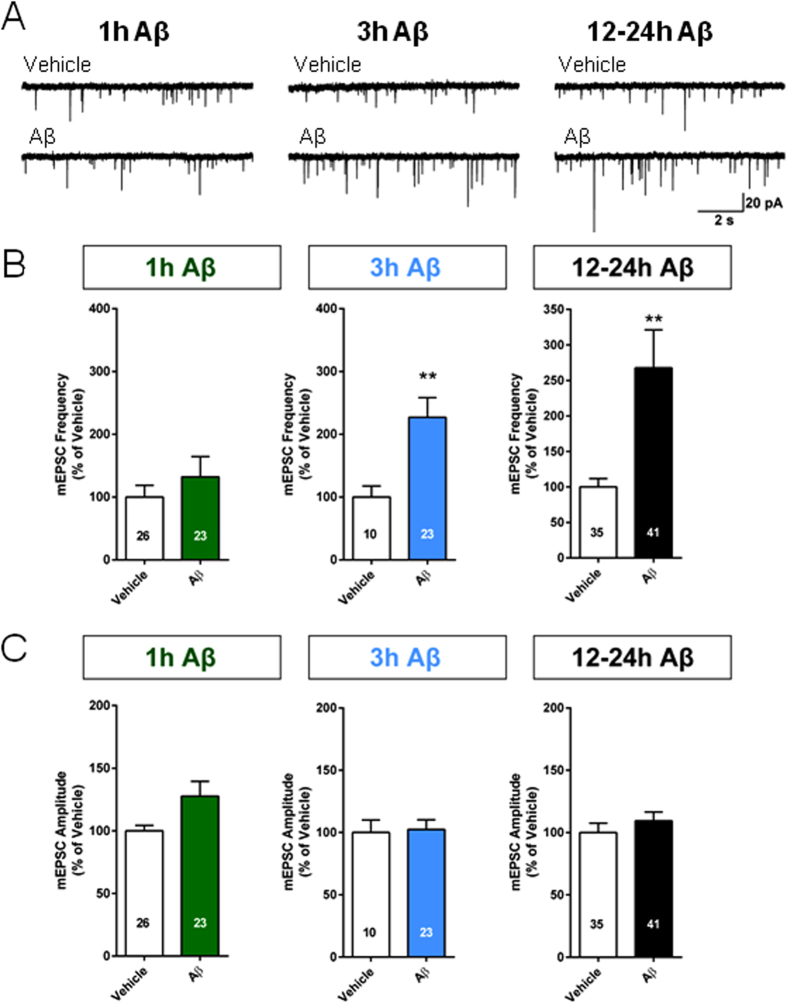
Time-dependent effects of treatment with pM Aβ on miniature neurotransmission.(A) Example traces of mEPSCs in vehicle- and Aβ-treated neurons after 1, 3 and 12–24 hours. (B) The frequency of spontaneous release of neurotransmitter was slightly increased, albeit not significantly, compared to vehicle treated cultures, after one hour (left) of perfusion with 200 pM Aβ42 (P = 0.581). The increase became significant after 3 (middle) (P = 0.009) and 12–24 hours (right) perfusion (P = 0.005) **P < 0.01, Mann-Whitney test. (C) At no time point was the amplitude of miniature events affected (P > 0.05, Mann-Whitney test).